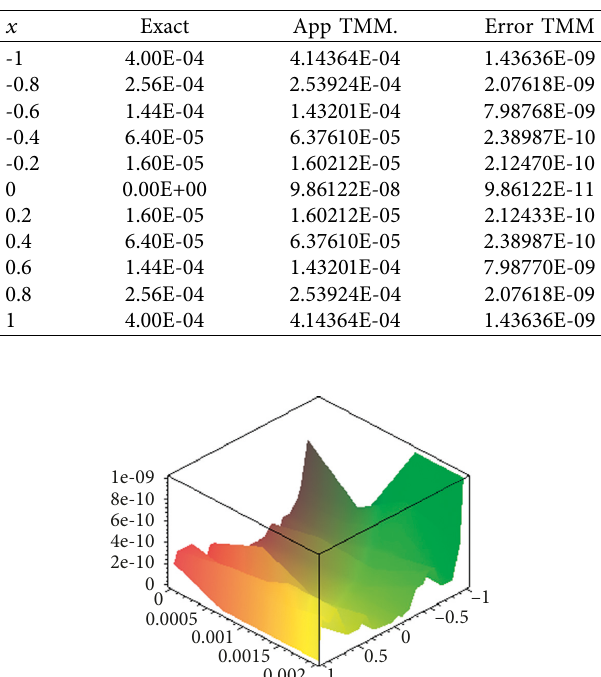
Table 4: Represents the numerical solution of equation (1) with logarithmic kernel and the error of TMM.